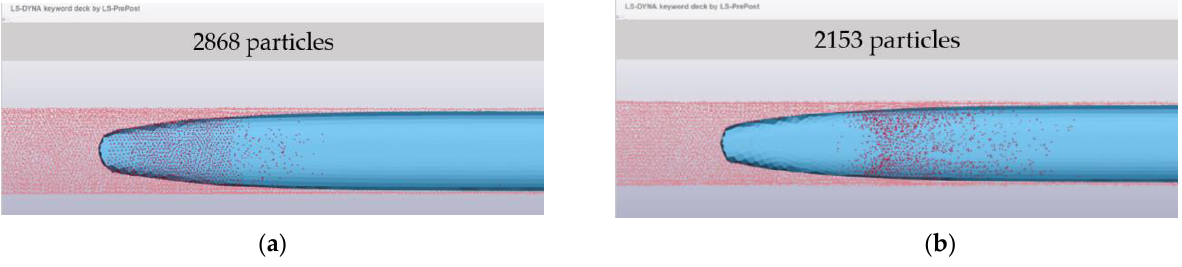
Figure 11. These are the two working conditions of Scenario 3: ( a ) conditions in the sixth-level sea state when waves hit the hull, and ( b ) conditions when the sixth- level sea state’s sea spray particles settle .